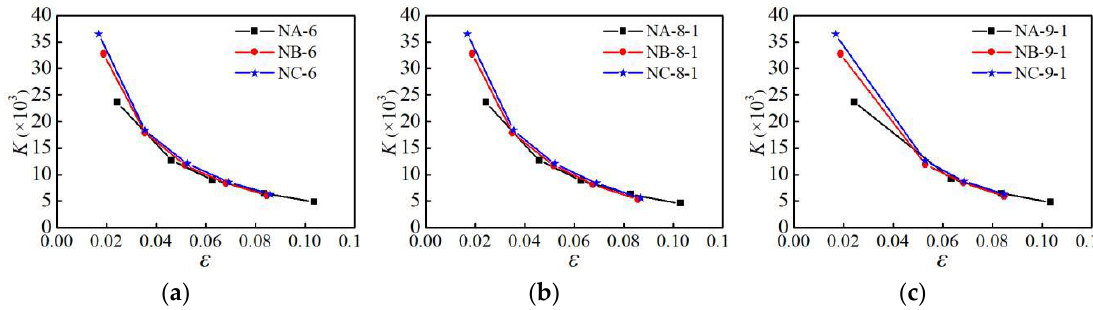
Figure 19. Influence of material type on secant stiffness: ( a ) loading patternNM-6; ( b ) loading pattern